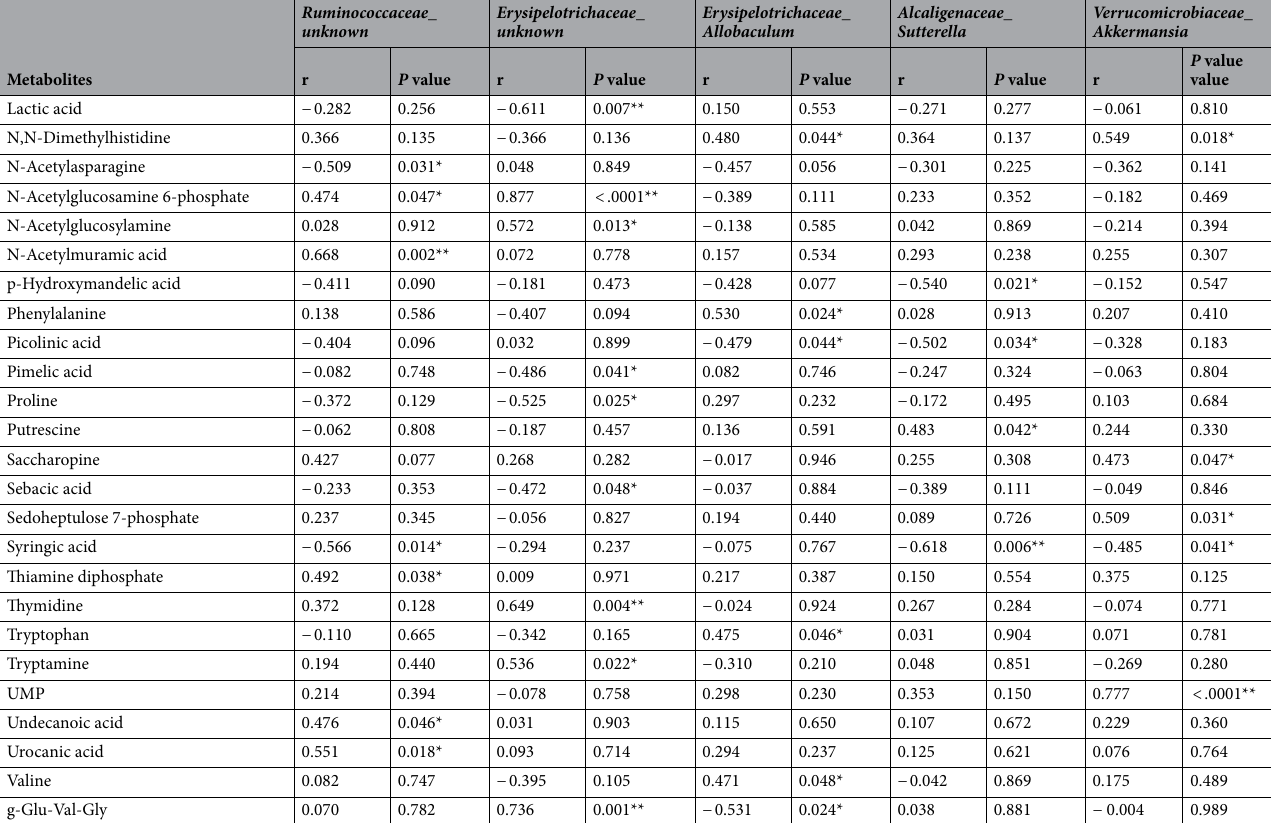
Table 3. Significant correlation between microbiota which correlate with Crps and metabolites. Blue: metabolites correlated with Crps, red: * P < 0.05, ** P <